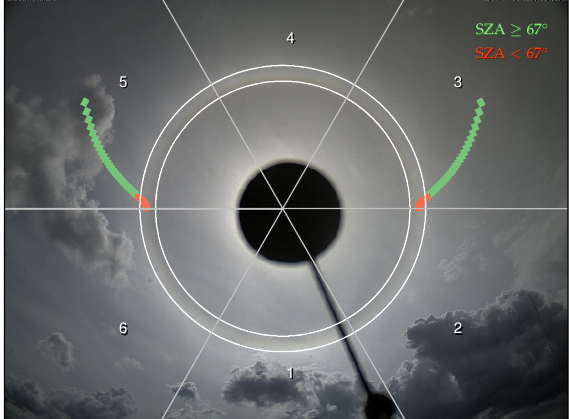
Figure 9. HaloCam image as in Fig. 4b. The red and green squares indicate the minimum scattering angle of the sundogs as a function of the solar zenith angle (SZA). The SZA ranges between 90 and 35 ◦ with 1 ◦ resolution. The mask used to search for the 22 ◦ halo peak is displayed by the two white circles and covers scattering an- gles between 21.0 and 23.5 ◦ . Sundog positions located within this mask might be misclassified as 22 ◦ halo and are marked as red. These positions correspond with SZAs between 90 and 67 ◦ . For smaller SZAs (higher solar elevations) the sundogs are located out- side the mask and cannot be misclassified as 22 ◦ halo by the algo-